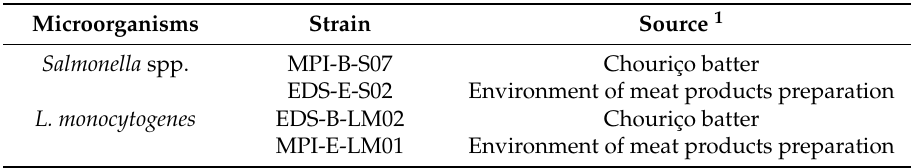
Table 1. Strains used in the